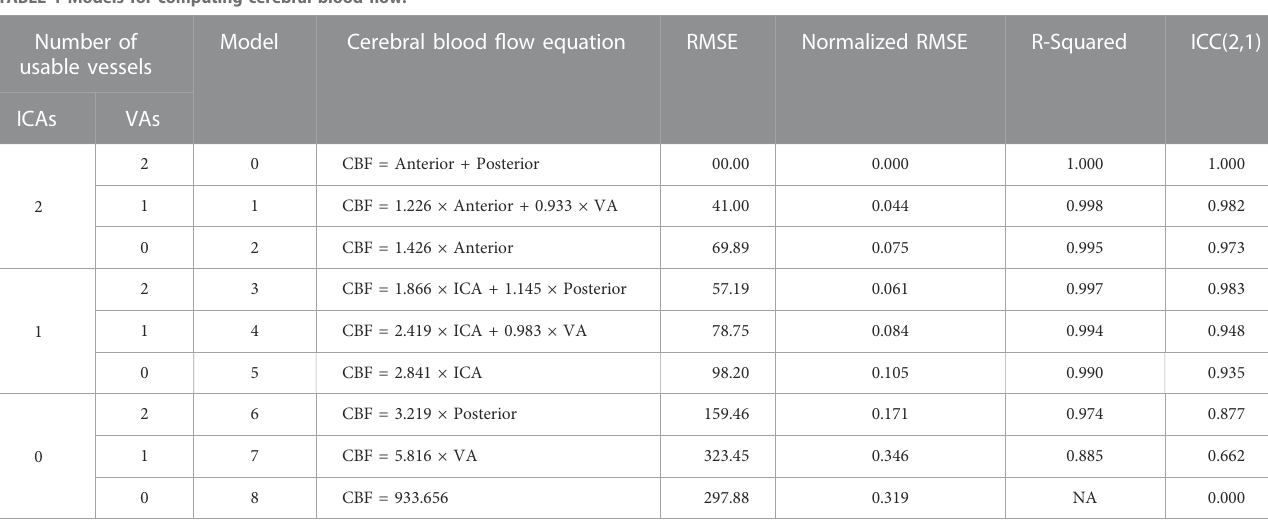
TABLE 1 Models for computing cerebral blood fl